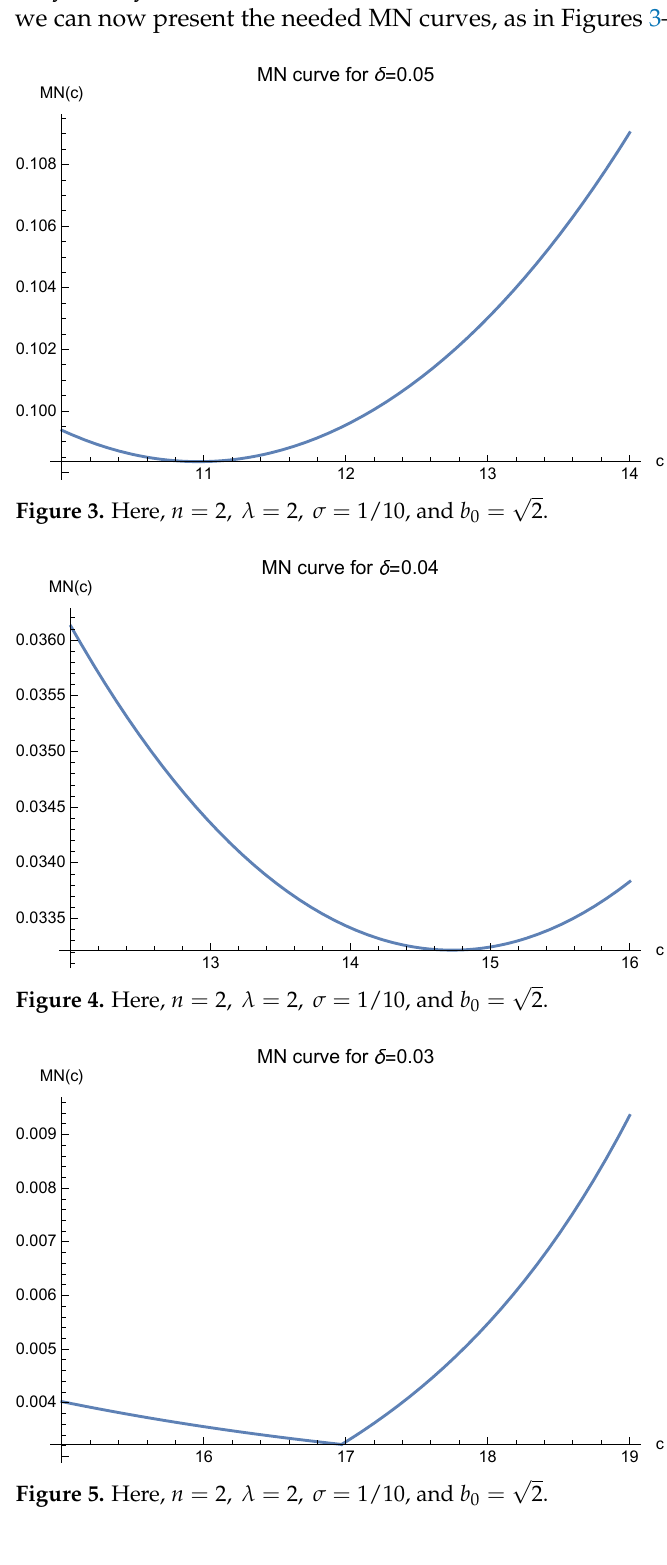
Figure 5. Here, n = 2, λ = 2, σ = 1/10, and b 0 =